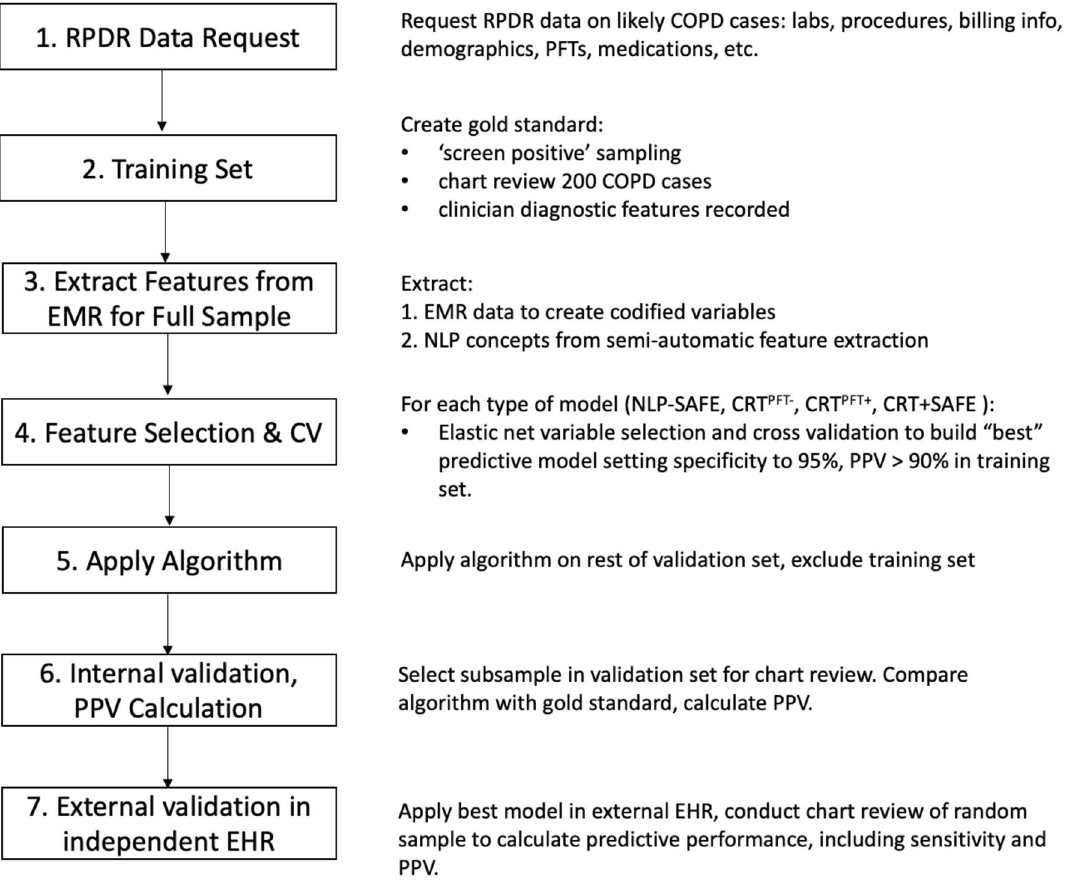
Figure 2. Broad overview of steps in phenotyping algorithm